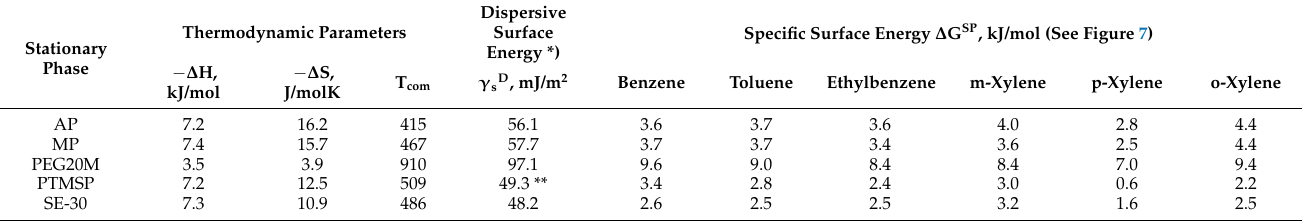
Table 3. Thermodynamic parameters of the sorption of the investigated stationary